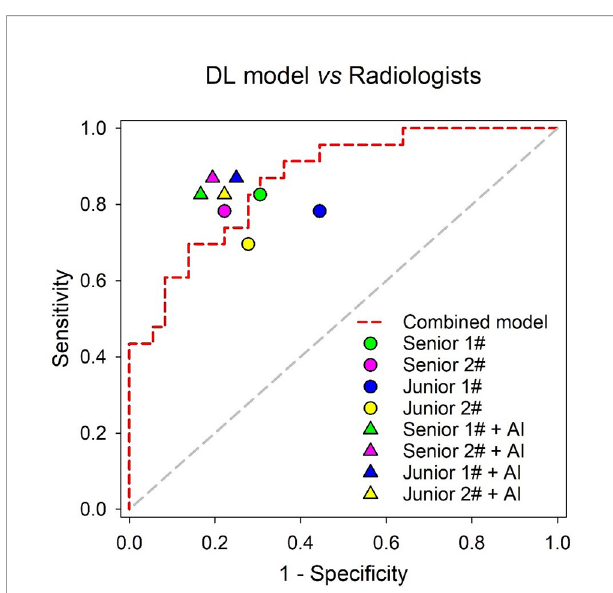
FIGURE 7 | Performance comparison of the Combined model and radiologists in the independent testing